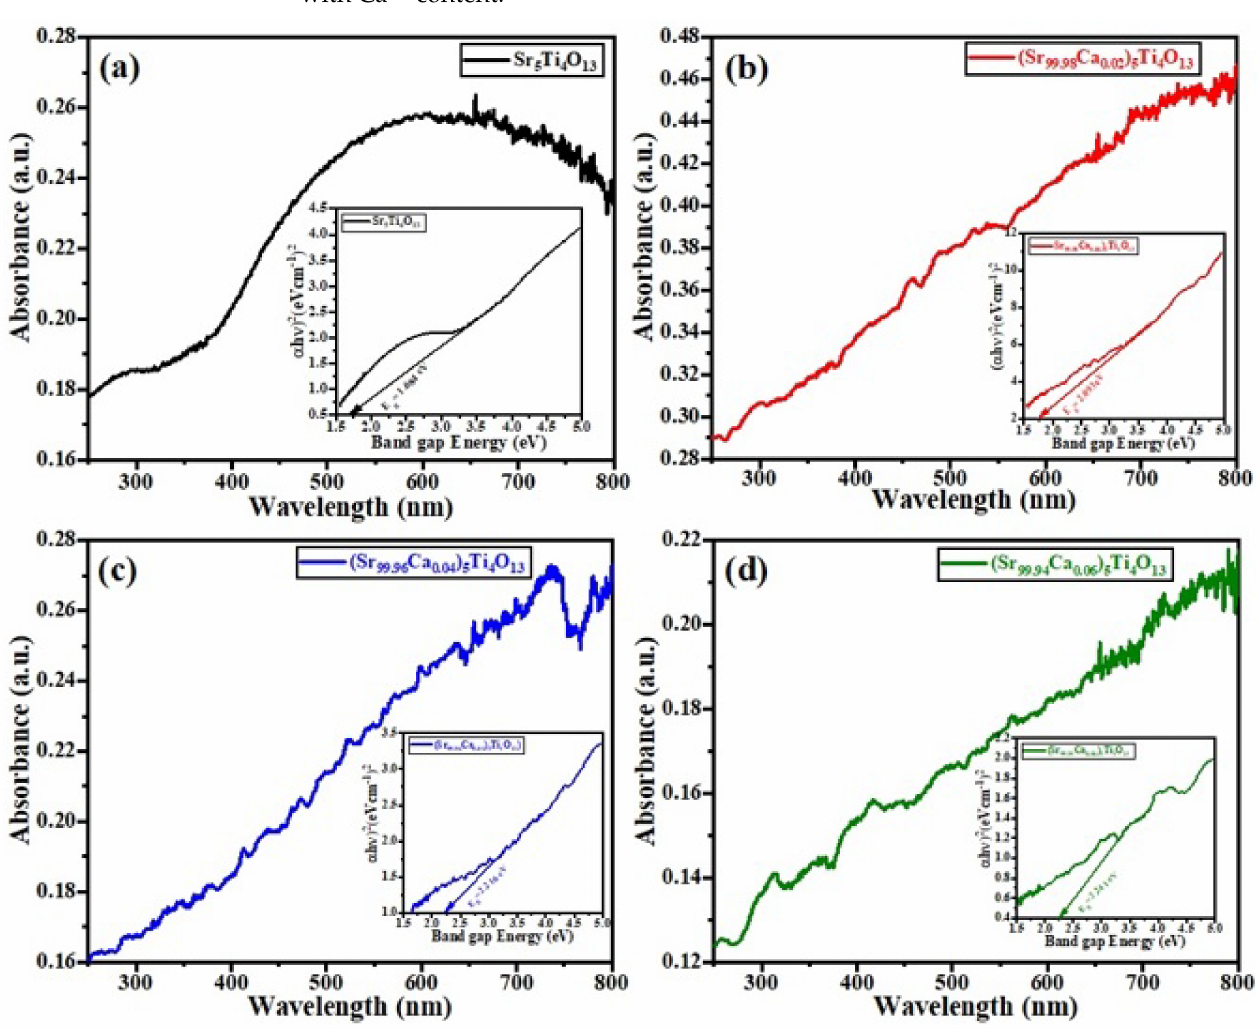
Figure 5. Band gap energies of (Sr 1 − x Ca x ) 5 Ti 4 O 13 , 0.0 ≤ x ≤ 0.06 ceramics i.e., ( a ) 1.684 eV ( b ) 2.093 eV ( c ) 2.216 eV & ( d ) 2.241